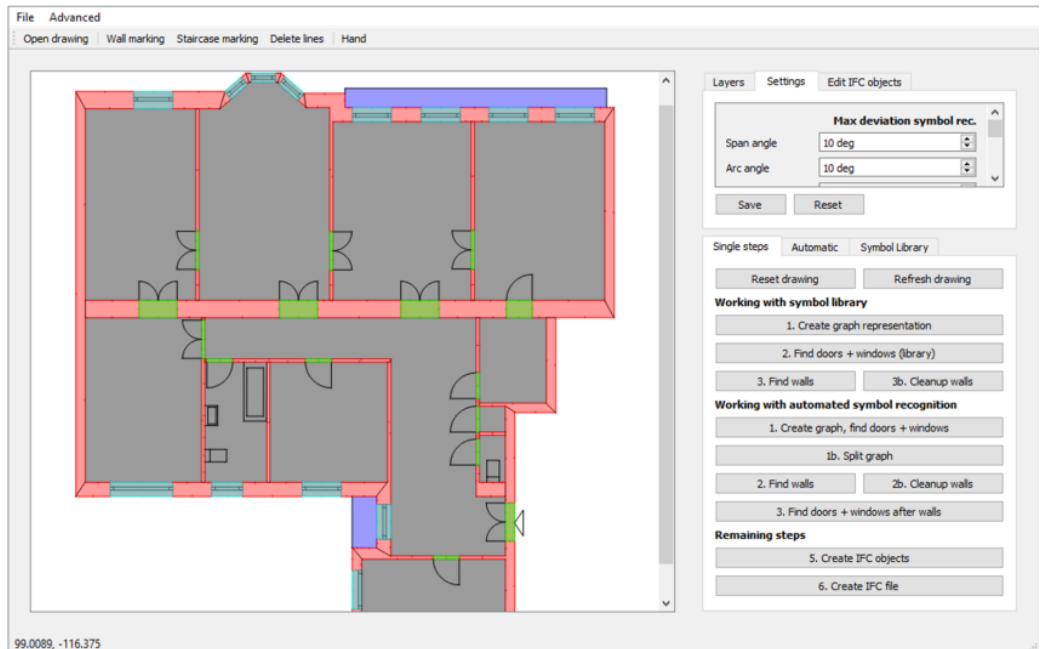
Figure 13. Graphical user interface to supervise the individual steps in the detection process.